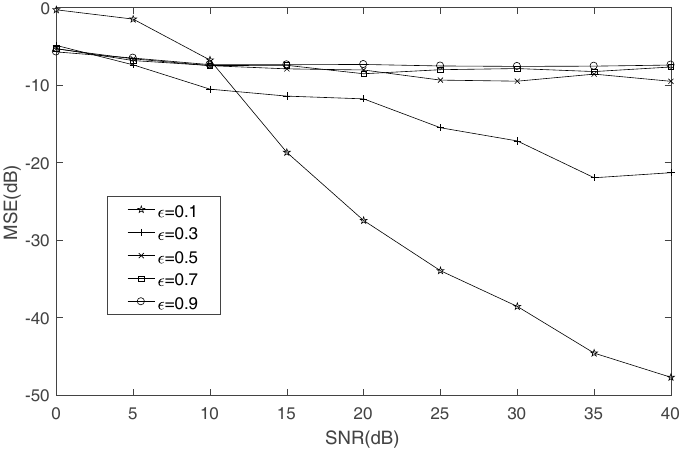
Figure 7. The effect of ε on mixing matrix.